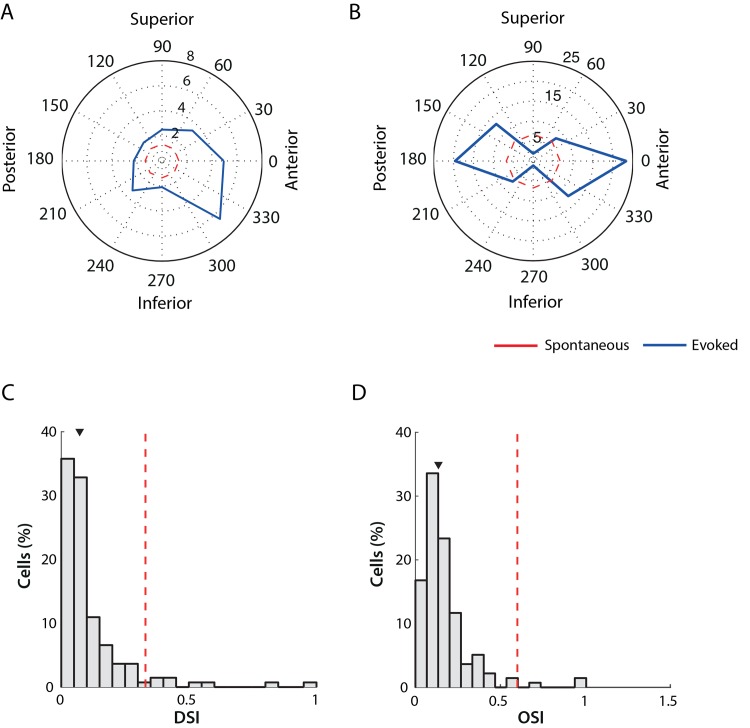
Direction/orientation selectivity in mouse LGN.Panels A and B show examples of single DS/OS neurons that responded preferentially to direction (A), and to anterior-posterior orientation (B). Radial units are spikes/sec. The red dashed line indicates the spontaneous activity level. C) Distribution of Direction-Selectivity Index values. The red dashed lines indicate the threshold for classification (0.33) and the arrow marks the median of the distribution 0.071 (0.038, 0.12). D. Distribution of Orientation-Selectivity Index values. The red dashed lines indicate the threshold for classification (0.6) and the arrow marks the median of the distribution 0.13 (0.082, 0.20).